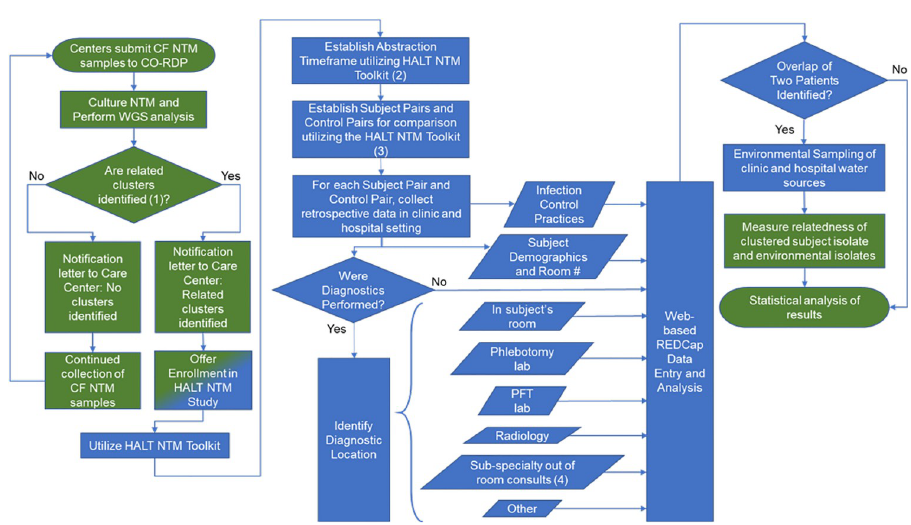
Fig 1. Schematic showing an overview of the healthcare-associated links in transmission of nontuberculous mycobacteria among people with cystic fibrosis (HALT NTM) study.